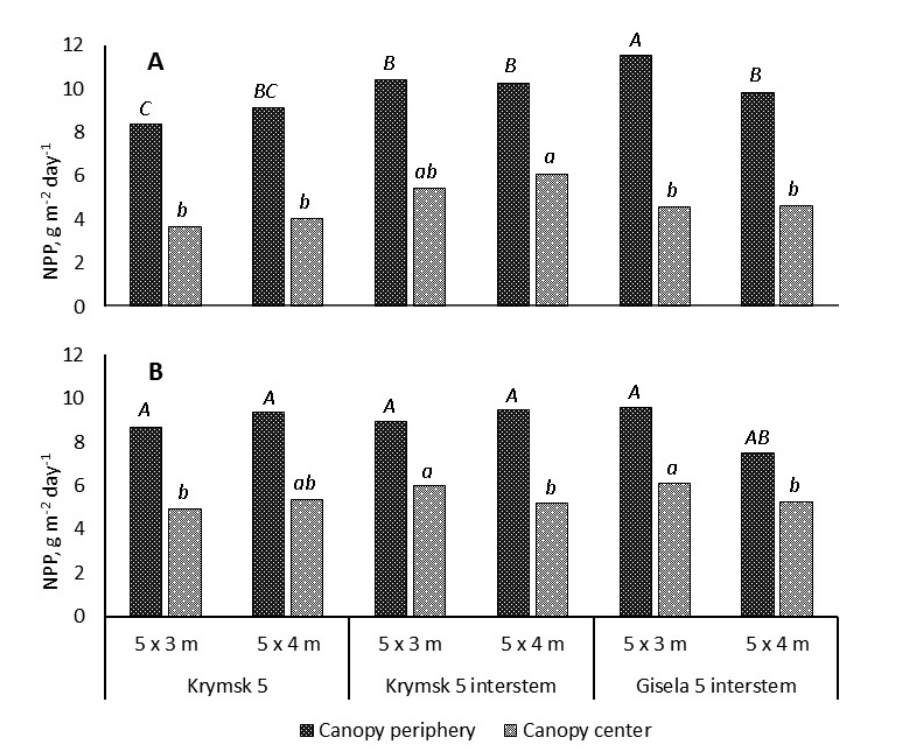
Figure 2: Net photosynthetic productivity of ‘Melitopolska chorna’ (A) and ‘Krupnoplidna’ (B) sweet cherry trees in different zones of the canopy, average for